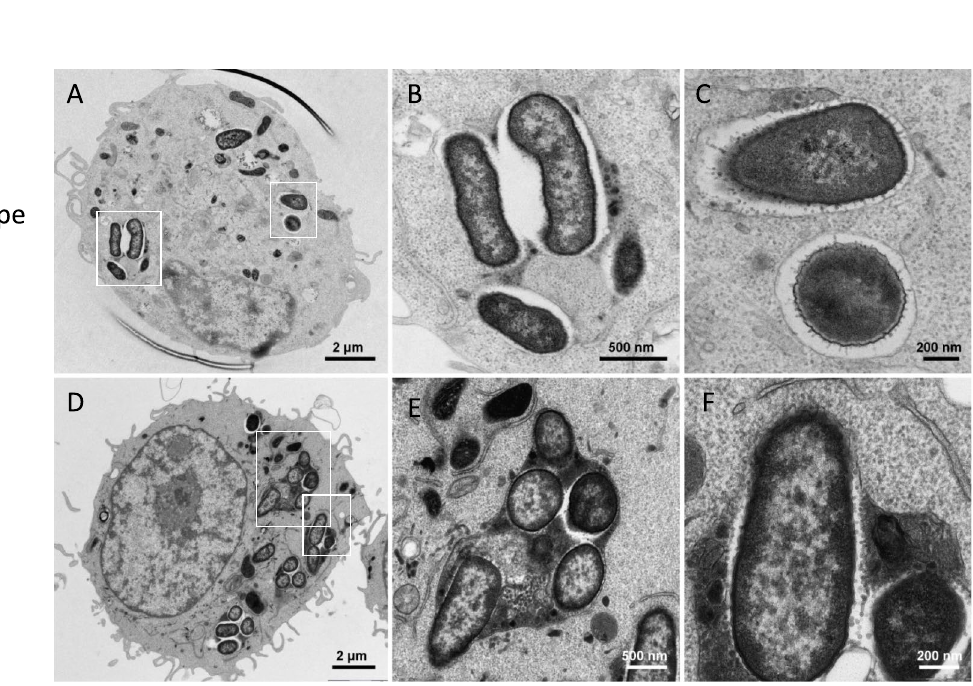
Figure 4. Transmission electron micrographs (TEM) of P. aeruginosa within macrophages. J774 macrophages were infected with P. aeruginosa wild-type strain or oprF mutant for 50 min after phagocytosis and subjected to TEM to visualize intracellular bacteria. For the wild-type strain, most of bacteria were found inside membrane bound vacuoles ( A – C ) whereas oprF mutant was mostly found in phagolysosomes ( D – F ). ( B ) and ( C ) are showing details of the cell shown in ( A ) (white rectangles) at higher magnification, ( E ) and ( F ) show details of the cell shown in ( D ) (white